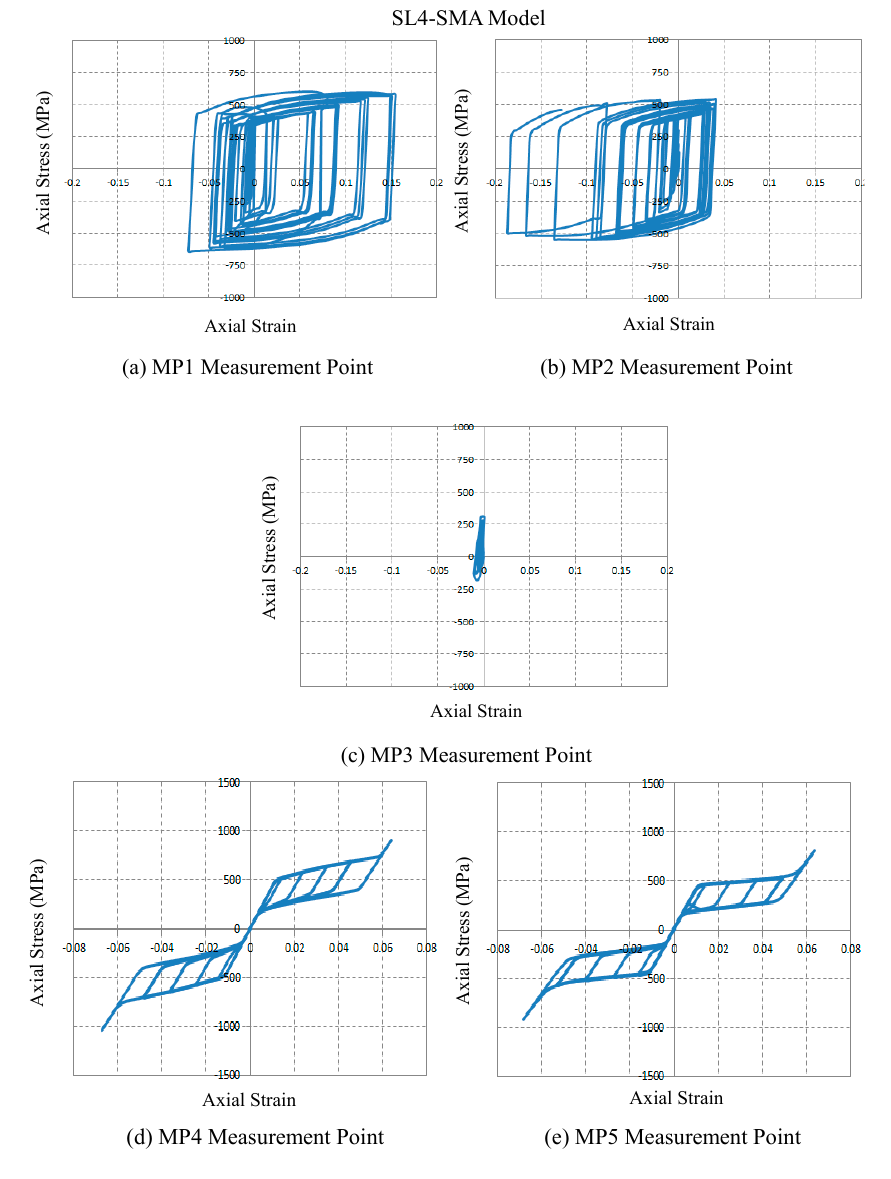
Figure 16. True stress and strain curves at the measurement points, ( a ): MP1 Measurement Point; ( b ): MP2 Measurement Point; ( c ): MP3 Measurement Point; ( d ): MP4 Measurement Point and ( e ): MP5Measurement